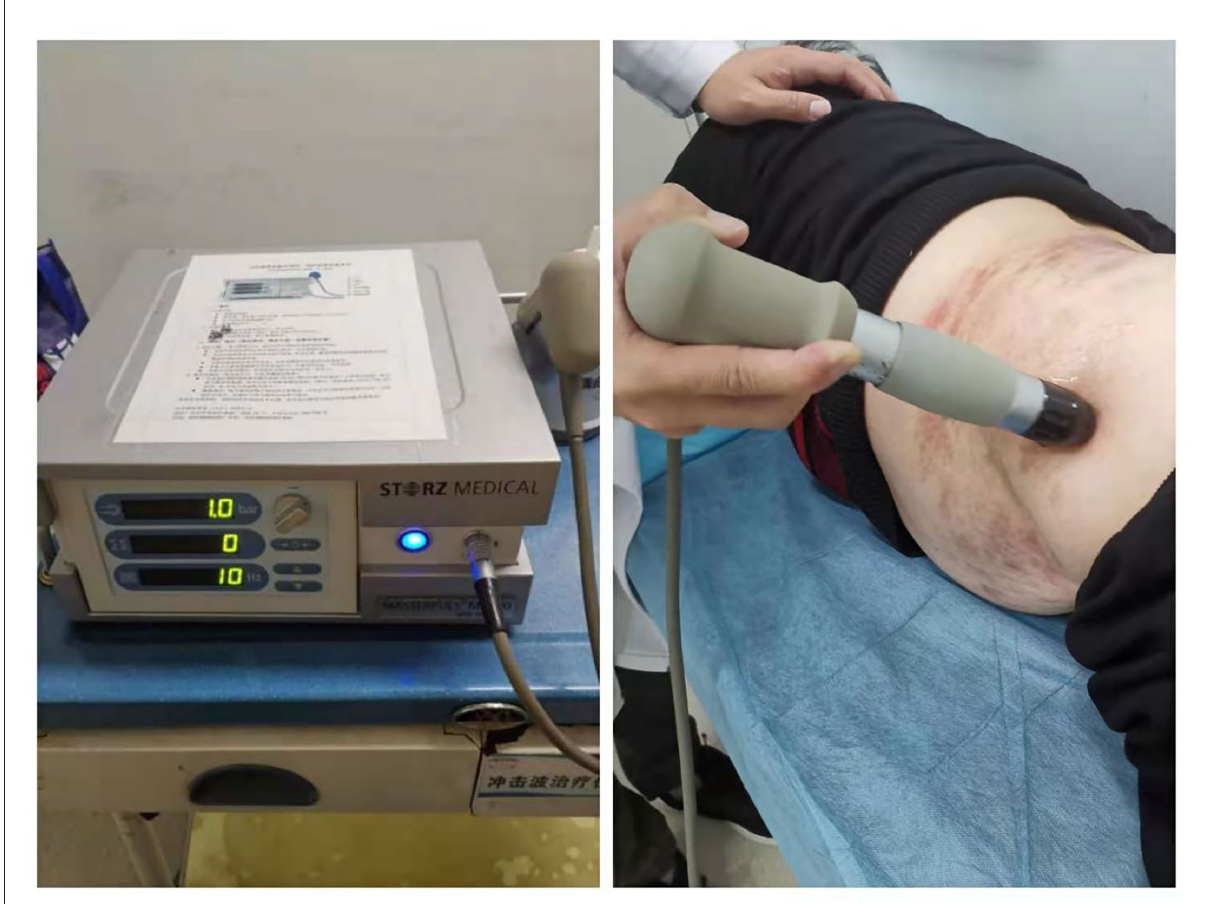
FIGURE1 Extracorporeal shockwave therapy (ESWT) for postherpetic neuralgia (PHN). The patient was treated by a radial extracorporeal shockwave generator (MASTERPULS MP100; Storz Medical AG, Switzerland) in a lateral